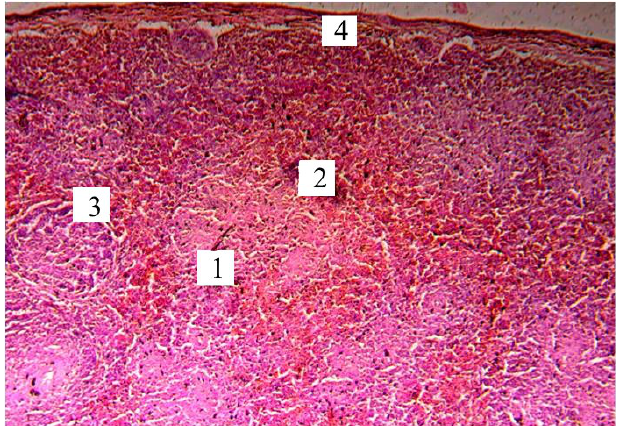
Fig. 5. Microscopic structure of the spleen of a 75-day- old vaccinated chicken: 1 – blood vessels; 2 – red pulp; 3 – white pulp. Hematoxylin and eosin. x